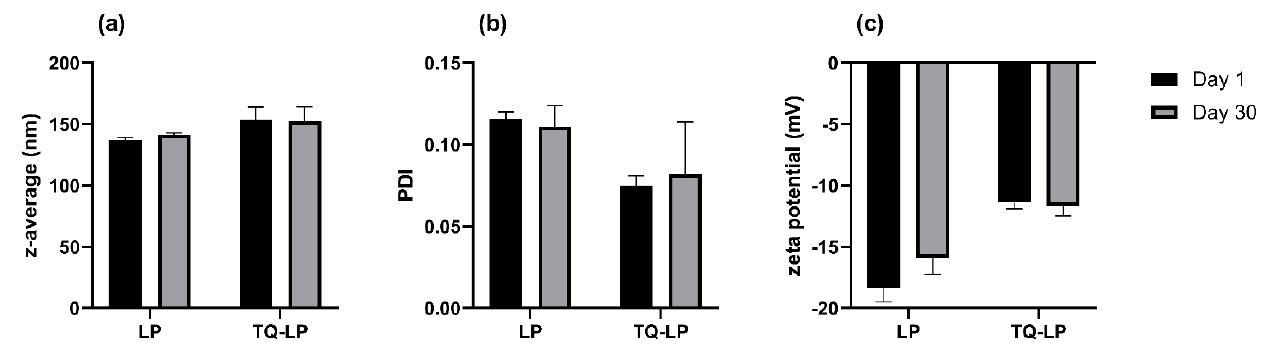
Figure 8. Size ( a ), size distribution ( b ) and zeta potential ( c ) of non-loaded (LP) and thymoquinone- loaded liposomes (TQ-LP) measured on the preparation day (day 1) and following 30 days of storage at 2–8 ◦ C (day 30). Table 1. Studied liposome samples and their composition and characterized parameters: thymo- quinone (TQ) load, z-average, polydispersity index (PDI), and zeta potential.